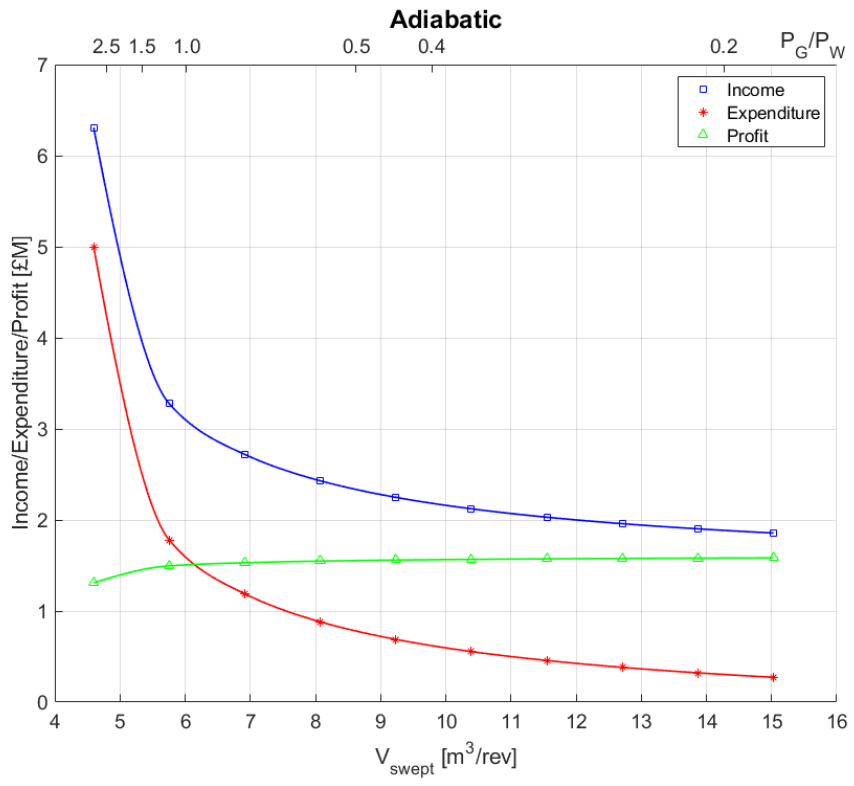
Figure 10. Income, expenditure and profit for representative isothermal ( above ) and adiabatic ( below ) systems with 200 h of storage. Also shown on the upper x-axes is the proportional power of COMG compared with COMW. Decreasing this ratio improves financial performance.